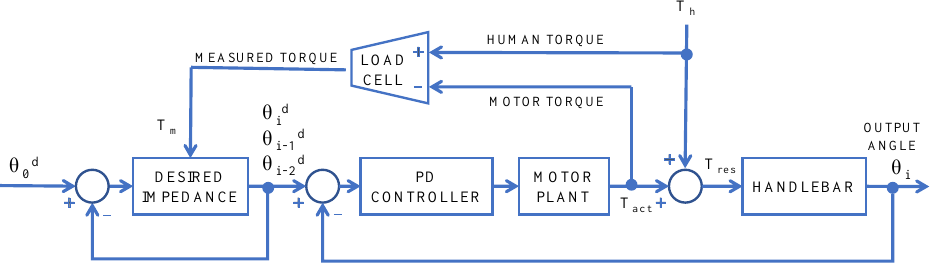
Figure 3. Block diagram of the control algorithm. The Desired Impedance block feeds the PD controller with a position reference, based on (4); thus, the motor and human torque actuate on the